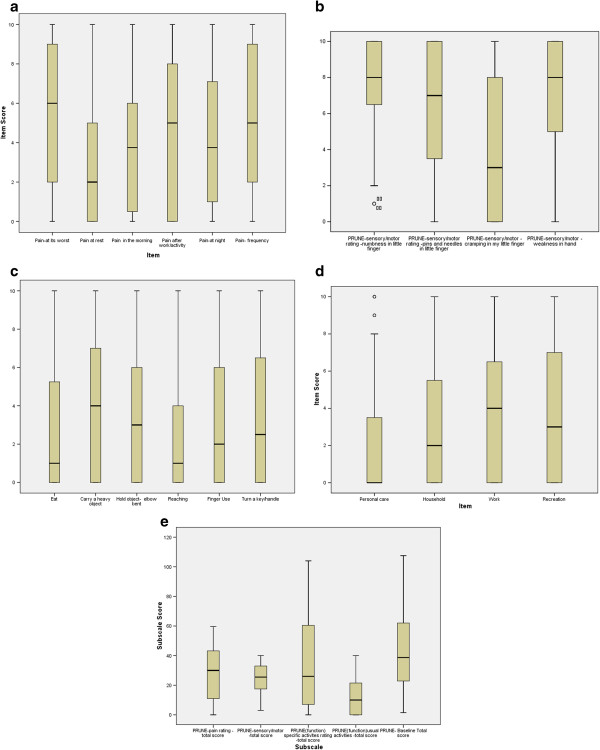
Boxplots of subscale items at baseline. a: Boxplot of Pain Items. b: Boxplot of Sensory/motor Symptoms Subscale. c: Boxplot of Items in Specific Activity Subscale. d: Boxplots of Items in Usual Activity Subscale. e: Boxplot of Subscale and Total Scores of Baseline PRUNE.